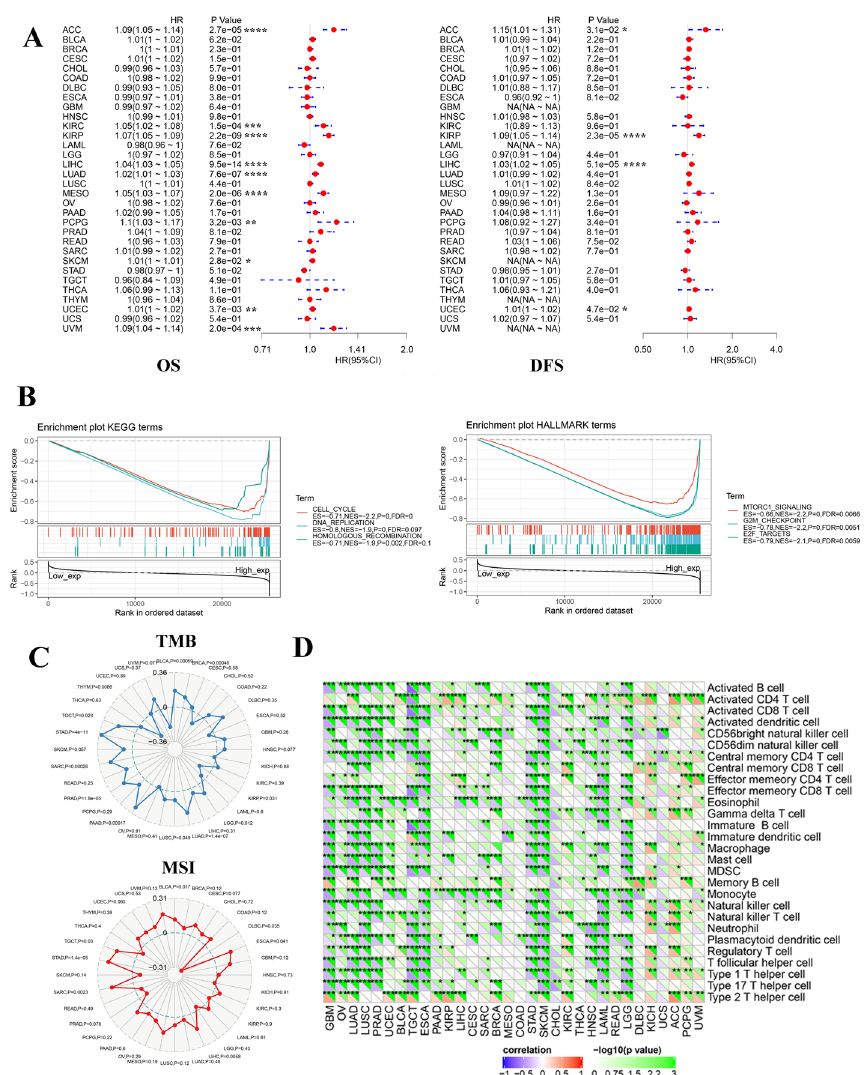
Fig. 3 Overview of UCK2 in human cancers. A Univariate Cox regression analysis estimating the prognostic value of UCK2 in different cancer types from TCGA database. B GSEA analysis revealed the signalling pathways of KEGG and Hallmark terms related to UCK2 in pan-cancer. C Correlation of UCK2 with TMB and MSI in different tumour types. D The correlation of UCK2 with immune cell infiltrating in different tumour types. * p < 0.05; ** p < 0.01; *** p < 0.001; **** p <